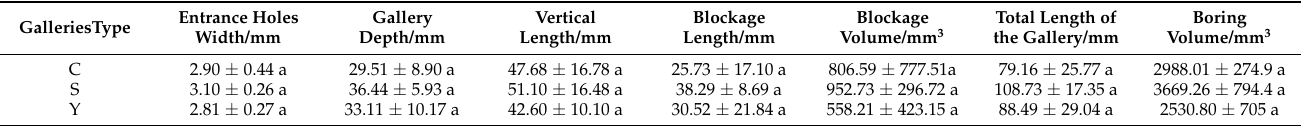
Table 1. Parameters of different gallery types of Monochamus alternatus . Data in the table refer to mean ± SE. The same letter within a column indicates no significant differences among treatments ( p >